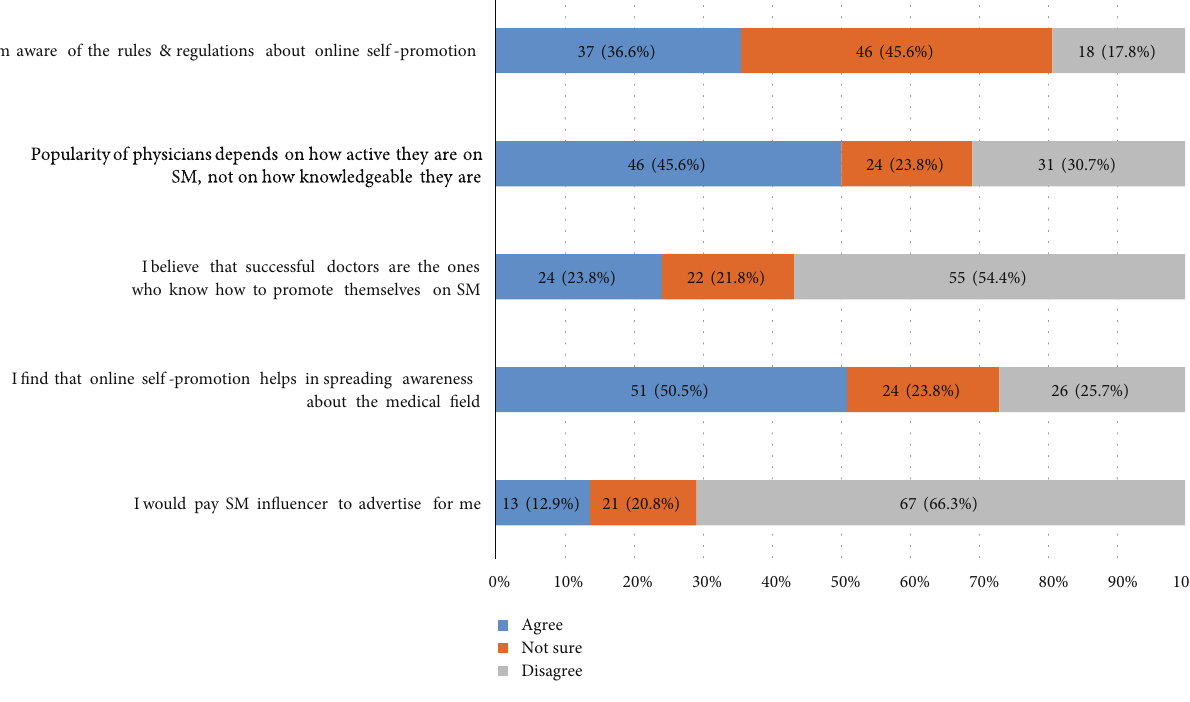
Figure 4: Self-promotion on social media (SM) and online platforms.